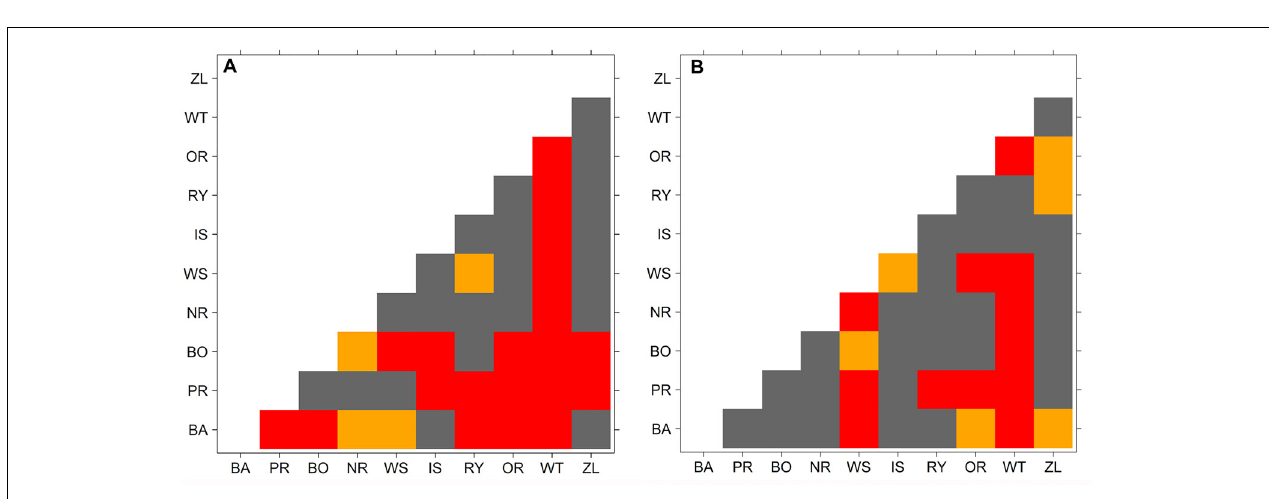
FIGURE 5 | Hierarchical clustering of the RWI provenance mean chronologies, using the Euclidean distance and Ward’s minimum variance clustering method. The letters KN and KR refer to Knyszyn and Kórnik site, letters BA, BO, PR, NR, IS, WS, RY, OR, WT, and ZL refers to Norway spruce provenances.